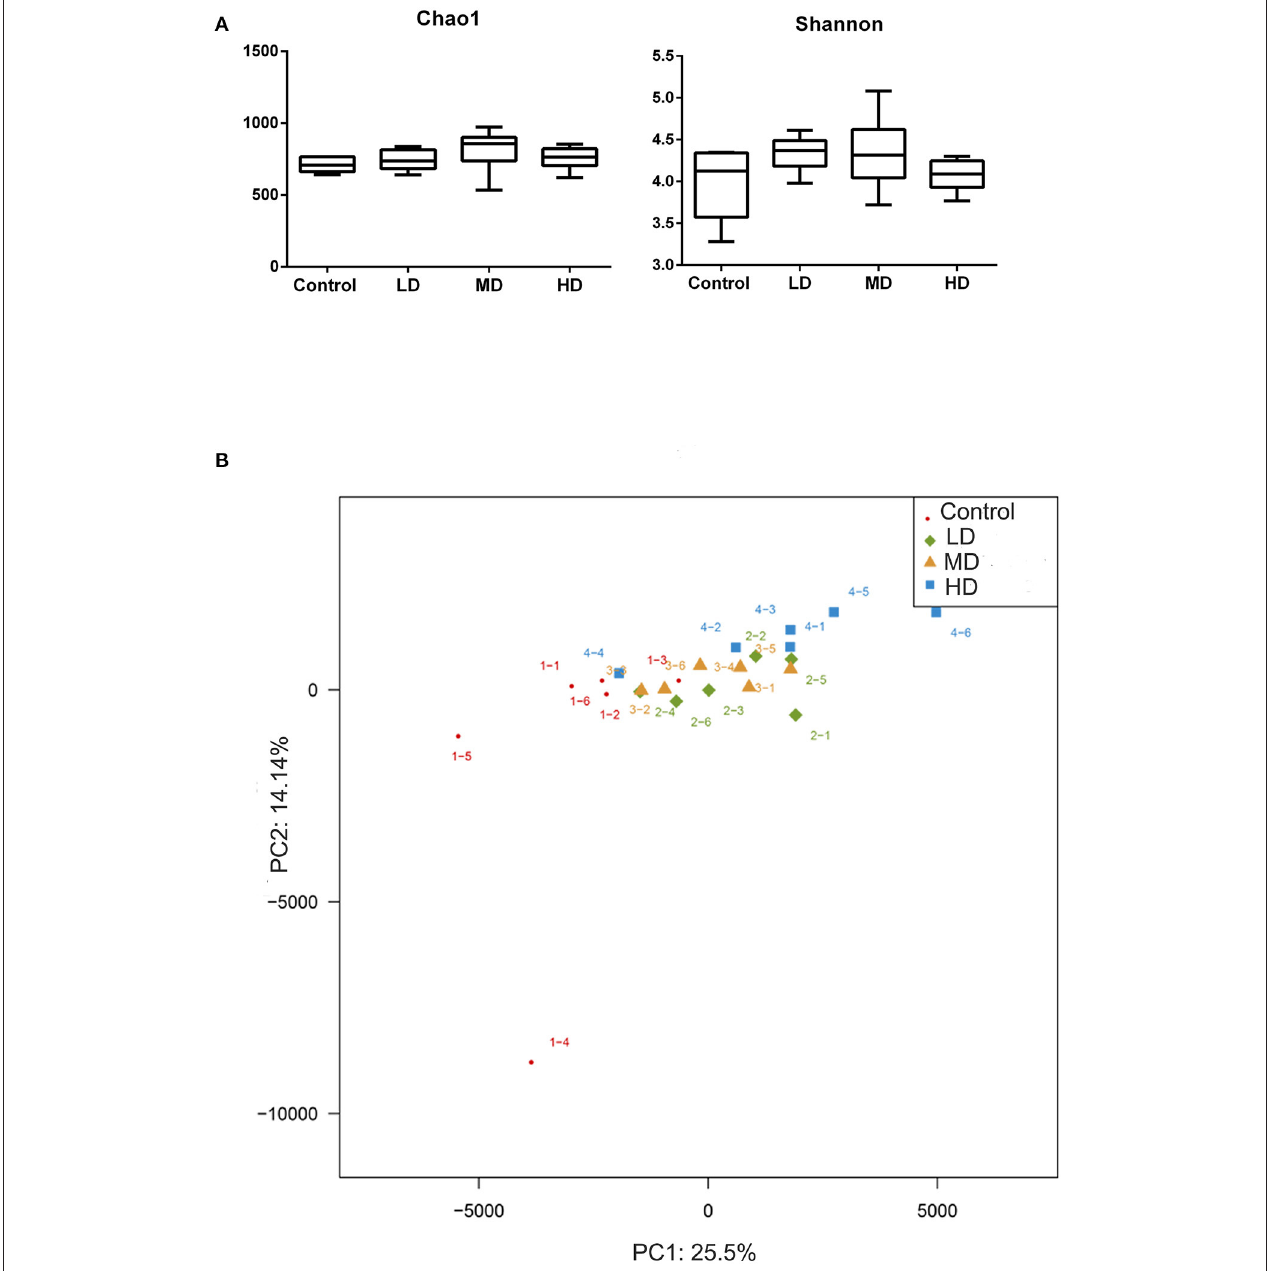
FIGURE 1 | Correlation of high red meat intake with gut microbiota. (A) The abundance and diversity of microbiota (Chao 1 and shannon index) in mice fed with different levels of red meat diets. (B) Principal Component Analysis (PCA) of microbiota in mice fed with different levels of red meat diets. LD, low-dose red meat group; MD, medium-dose red meat group; HD, high-dose red meat group.